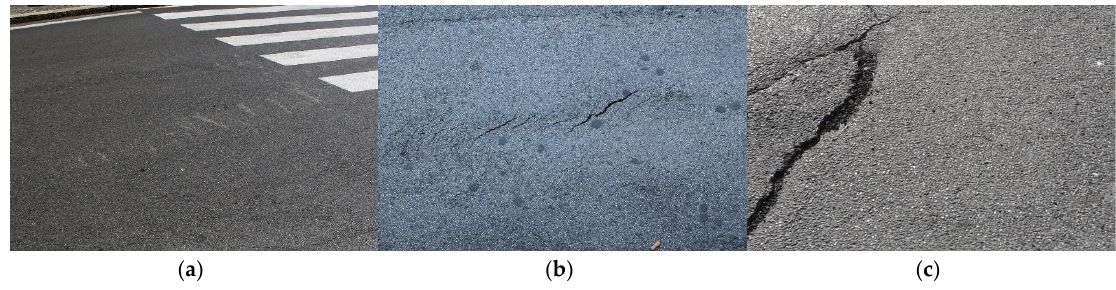
Figure A4. Slippage cracking. ( a ) Low Severity; ( b ) Medium Severity; and ( c ) High Severity.